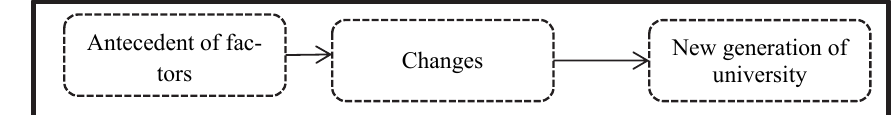
Fig. 1. The integrative process of the entrepreneurial